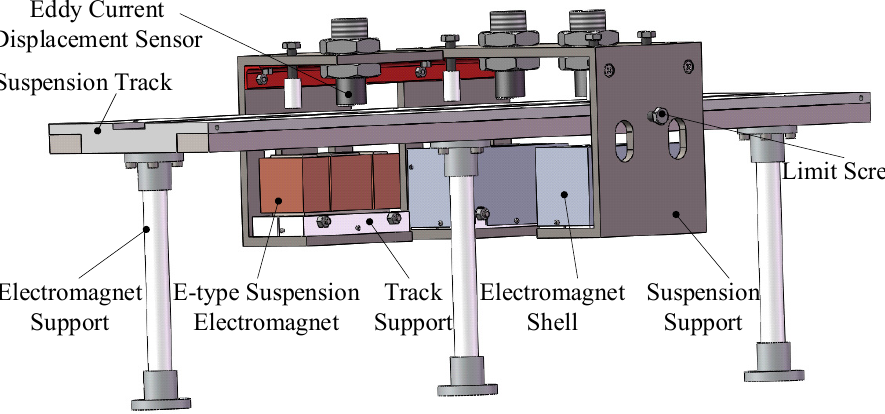
Figure 3. Structure diagram of magnetic bearing experimental device.